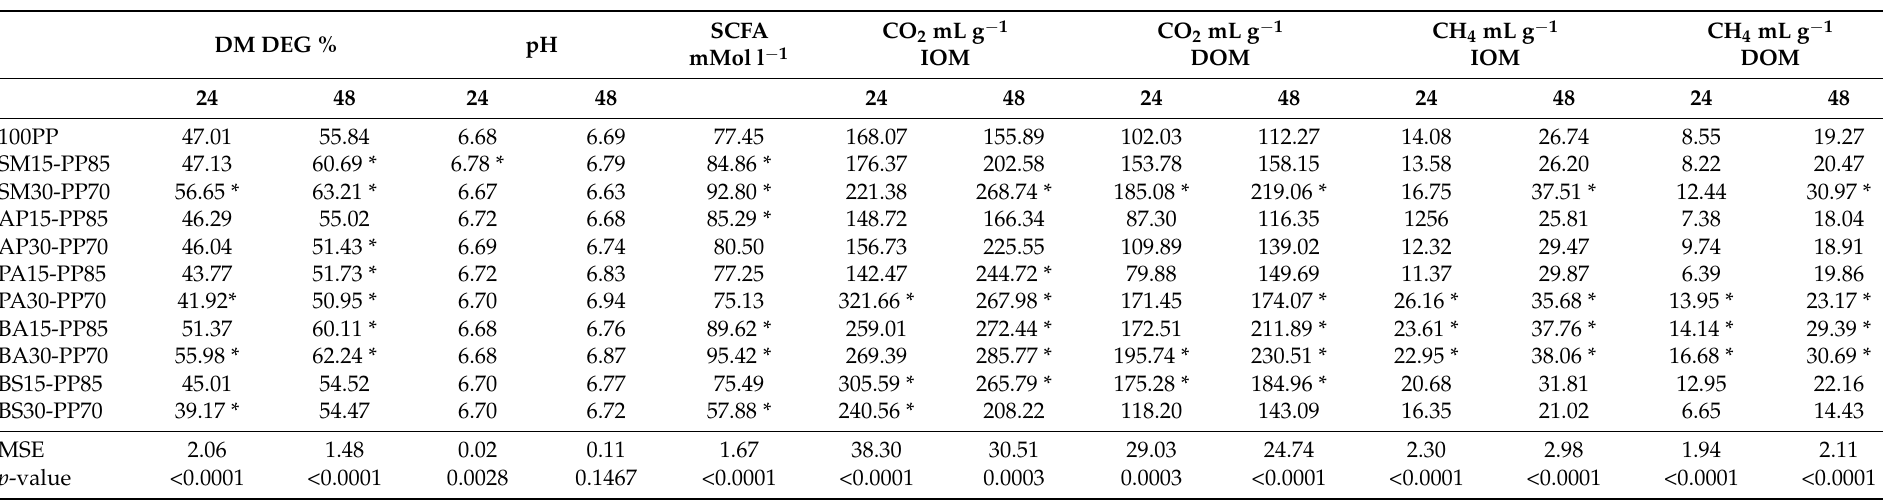
Table 4. DM degradability, pH, SCFA and CH 4 production at 24 and 48 h of incubation of forage species mixed with P. purpureum at two